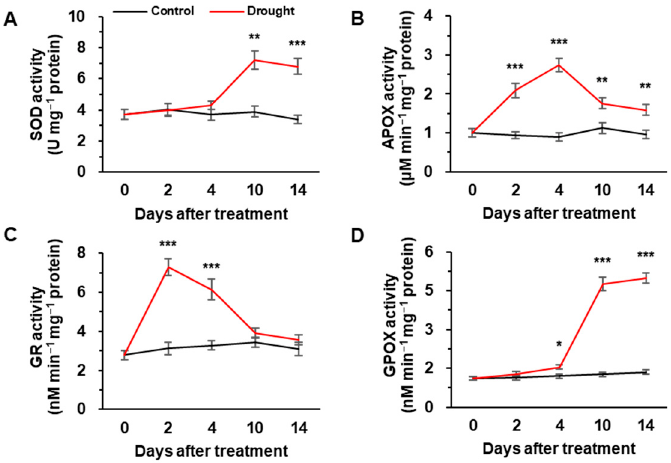
Figure 1. Changes in activities of superoxide dismutase (SOD, ( A )), ascorbate peroxidase (APOX, ( B )), glutathione reductase (GR, ( C )) and glutathione peroxidase (GPOX, ( D )) in the leaves of well-watered (control) or drought-stressed plants for 14 days. The black and red lines indicate control and drought stress, respectively. Data are represented as means ± S.E. for n = 4. Asterisks indicate a significant difference between well-watered and drought-stressed plants: * p < 0.05, ** p < 0.01, *** p < 0.001.